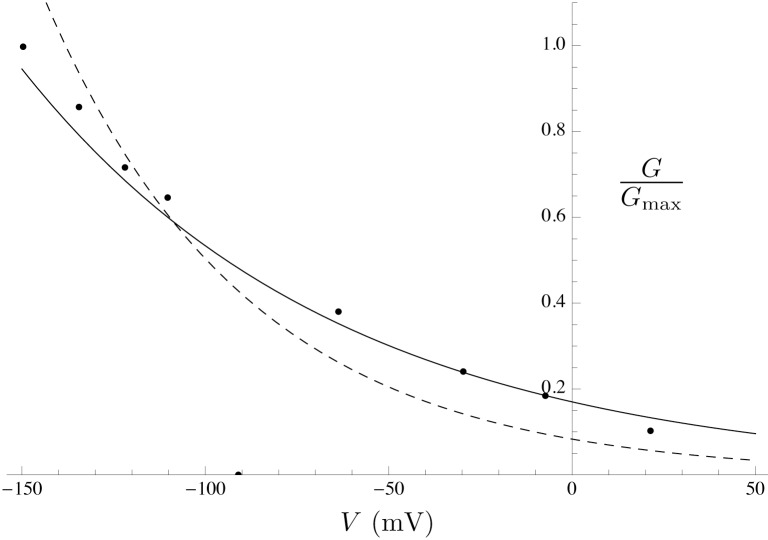
Simulations in support of Hypothesis III.(A) Simulated local calcium sparks; the panel to the right is an expanded time-axis representation of the boxed section (i). (B) Train of action potentials in response to driving the gating kinetics of a small proportion (5%) of the CaCC population with the simulated calcium sparks on top of the global cytosolic calcium concentration.